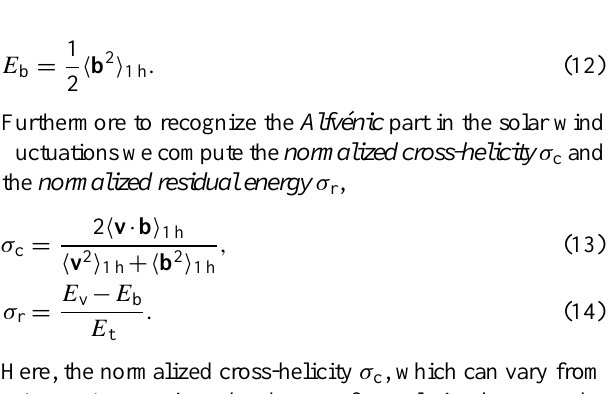
Fig. 3. The same of Fig. 2 for the sample at 5AU.